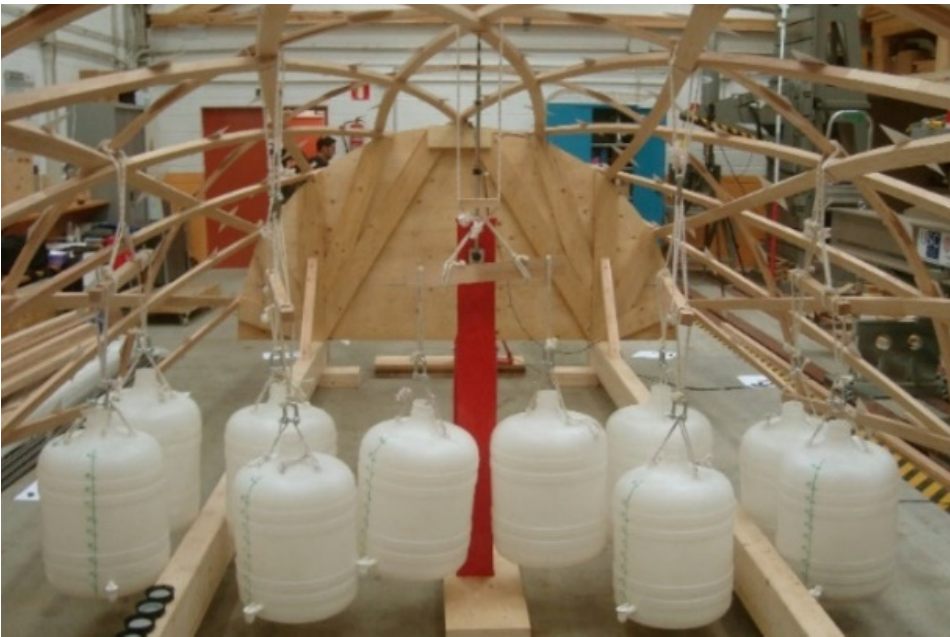
Figure 5. Interior view of the TEL-gridshell lab prototype during the load test.